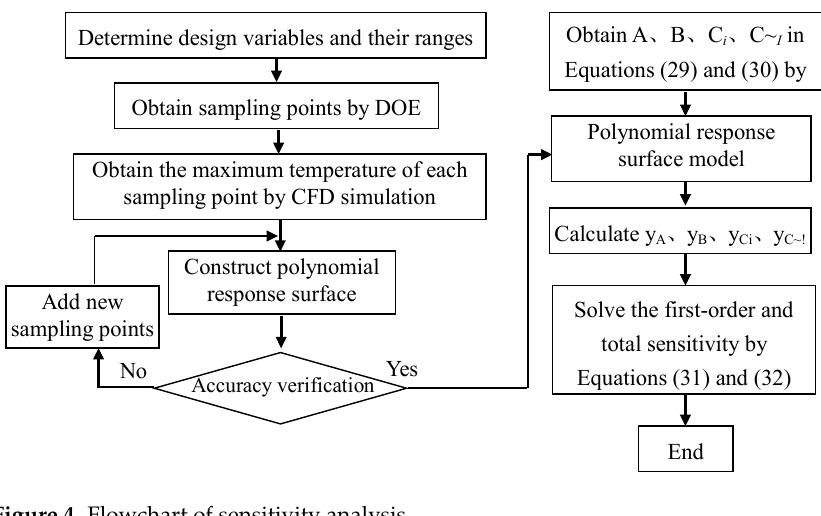
Figure 4. Flowchart of sensitivity analysis.